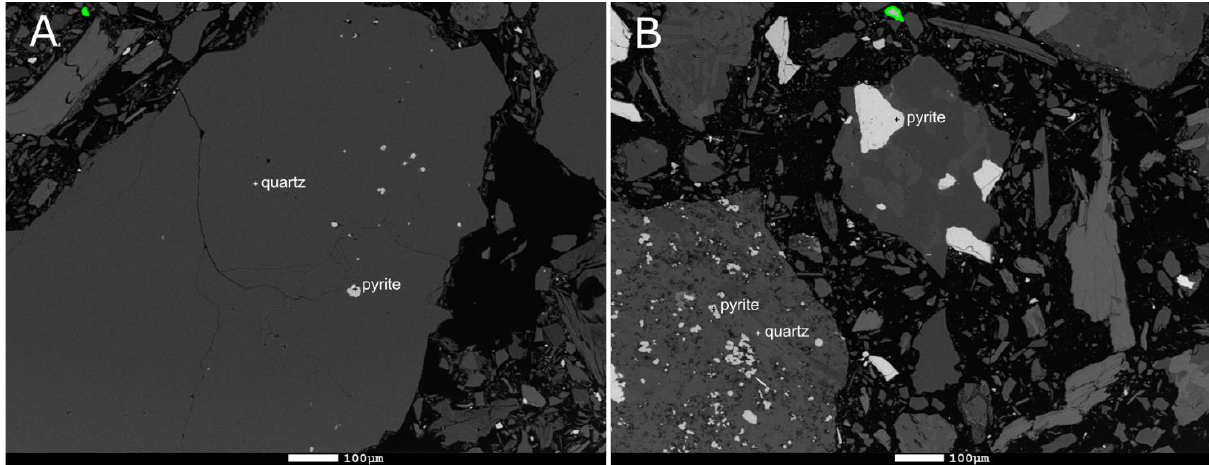
Figure 2. Backscatter electron images of the sample WR1 ( A ) and WR2 ( B ) showing pyrite inclusions in quartz.